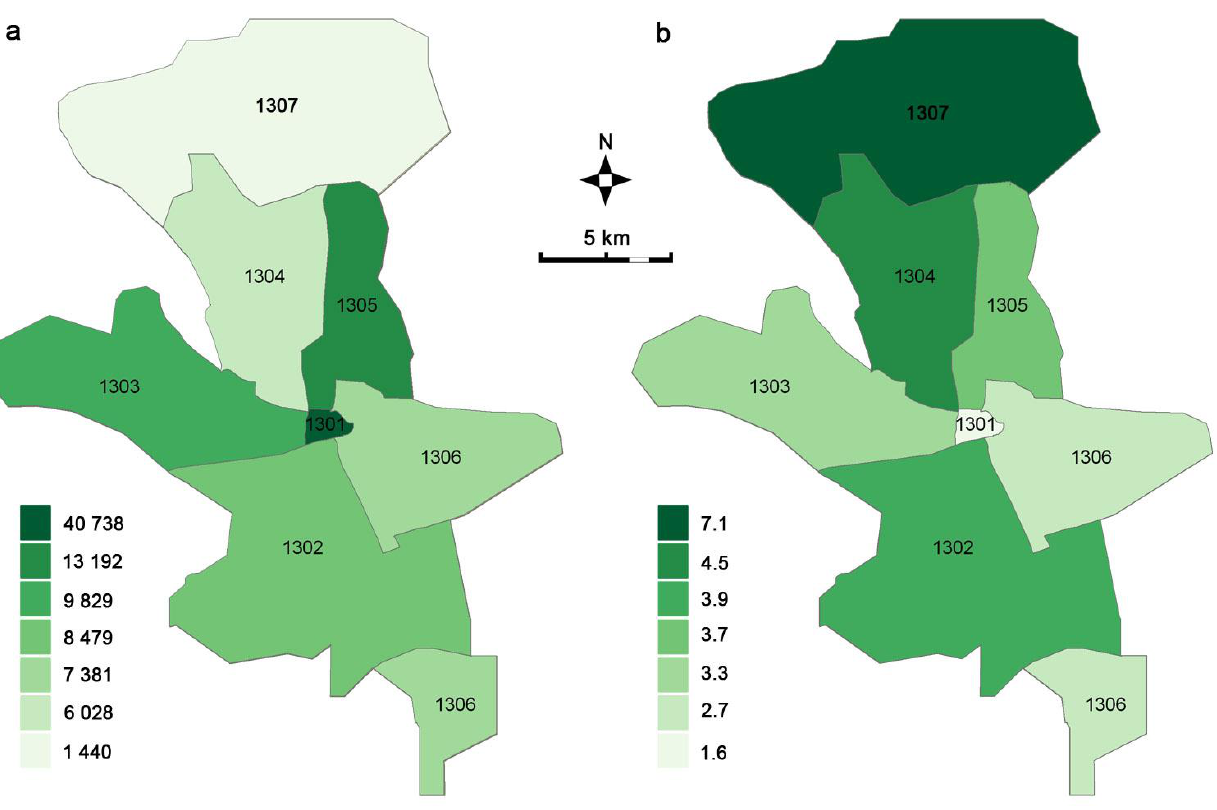
Figure 9. Population density per district [Population / km 2 ] for 2007 ( a ) and changes of population density per district between 2007 and 1994, displayed as ratio ( b